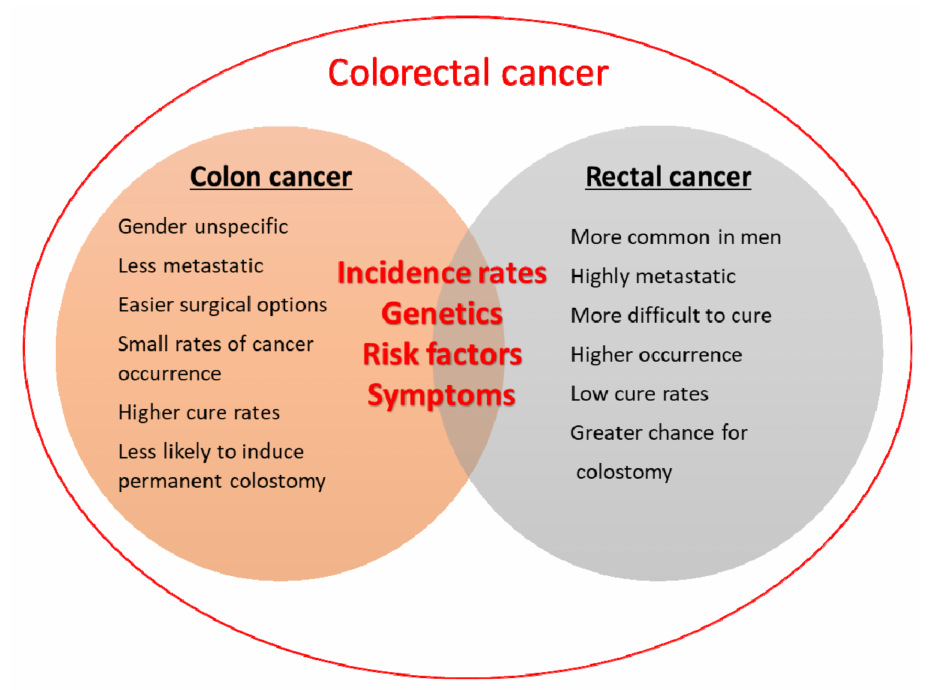
Figure 1. Comparison of colon and rectal